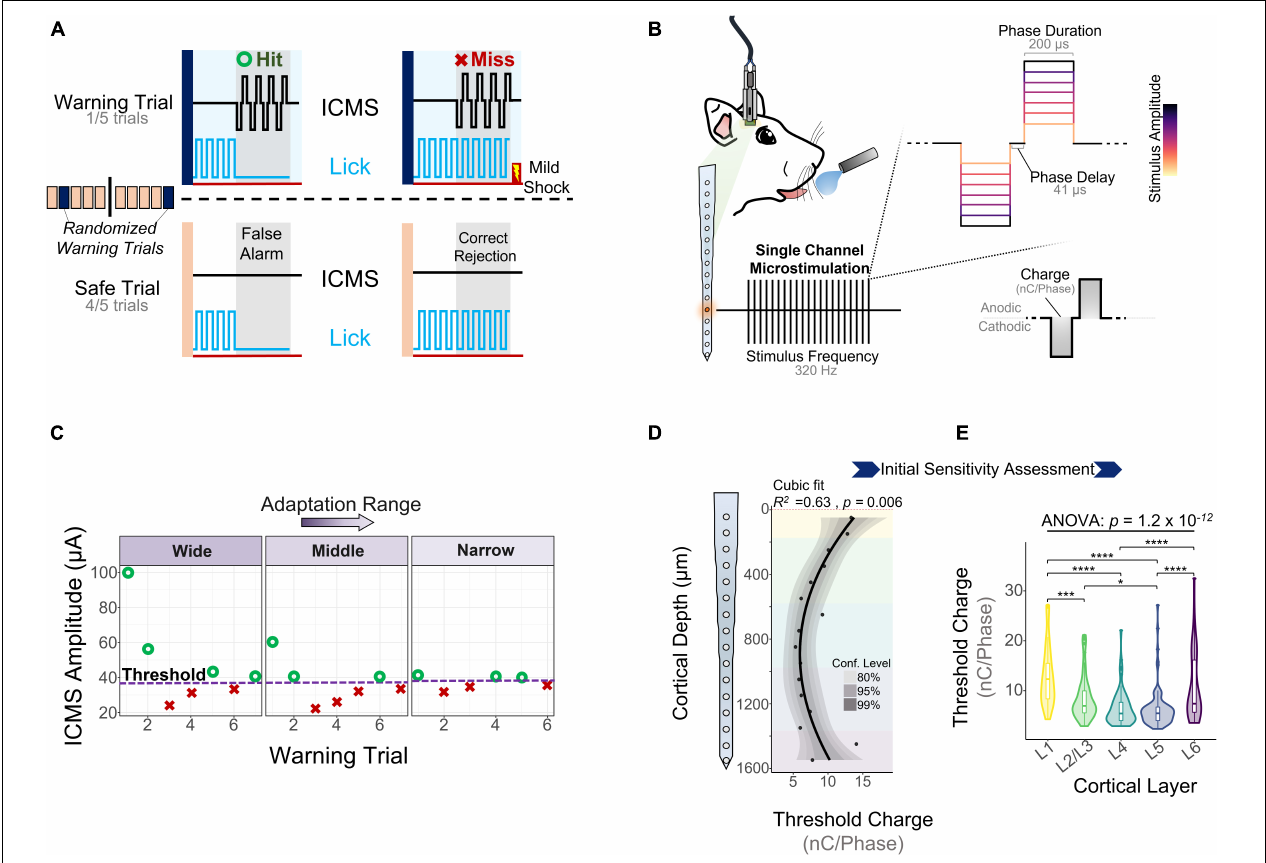
FIGURE 2 | Behavioral paradigm and microstimulation sensitivity over depth. (A) A conditioned avoidance behavioral paradigm was used to assess the ability of the animals to detect microstimulation. (B) Stimulation frequency, phase duration, and phase delay were kept constant throughout the experiment. Stimulus amplitude was modulated based on the animal’s behavior using an adaptation protocol. (C) Adaptation protocol used to measure detection thresholds. Similar detection thresholds can be obtained regardless of the initial stimulation amplitudes. (D) Sensitivity of S1 to microstimulation as a function of cortical depth during the first five experimental sessions ( N = 6). (E) Quantification of these thresholds across cortical layers (ANOVA with Tukey’s post-hoc test) ( N = 6). * p ≤ 0.05, *** p ≤ 0.001, **** p ≤